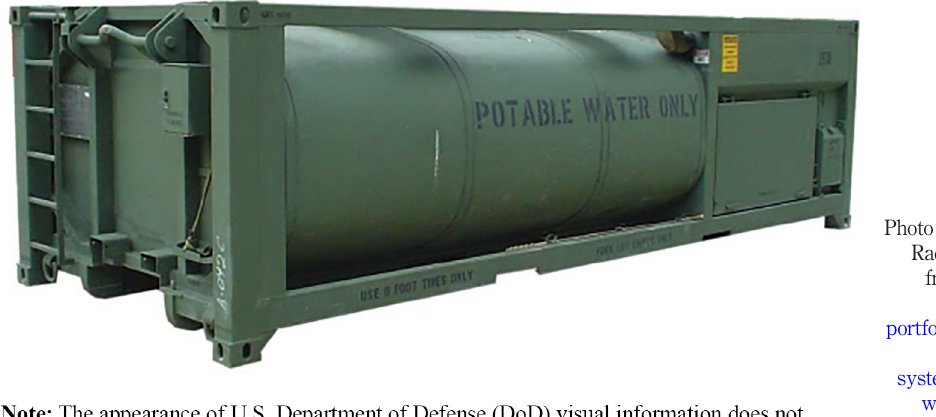
Figure 3. Photo of Water